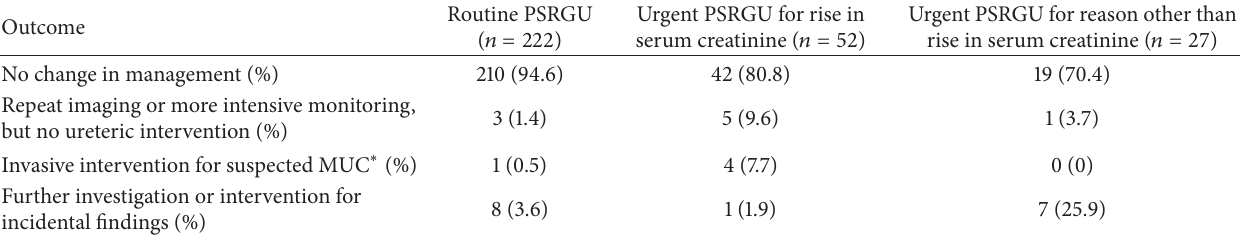
Table 3: Clinical outcomes following routine and urgent USS after elective stent